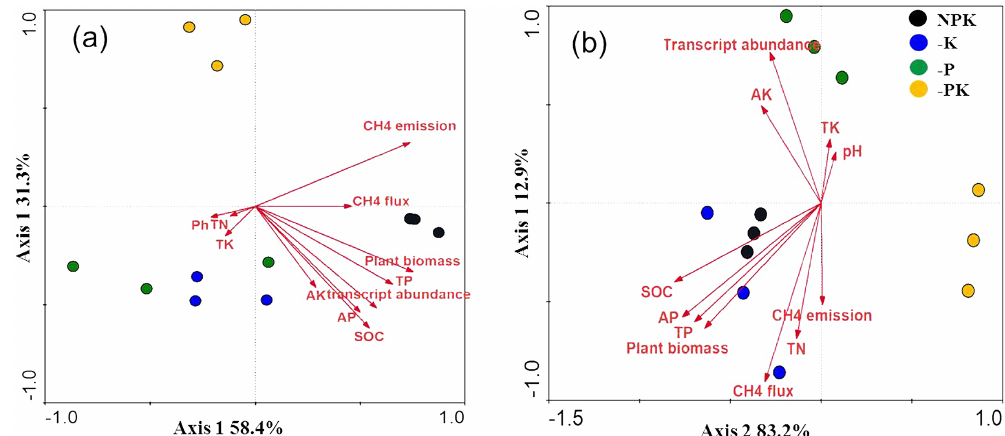
Figure 5. Redundancy analysis indicating relationships between soil properties, plant biomass and community structures of mcrA (a) and pmoA (b) gene transcripts from rice tillering stage. NPK: balance chemical fertilisation; − K: potassium deficient; − P: phosphorus deficient; − PK: phosphorus and potassium deficient. CH 4 emission: methane flux from field plots; CH 4 flux: methane flux from soil